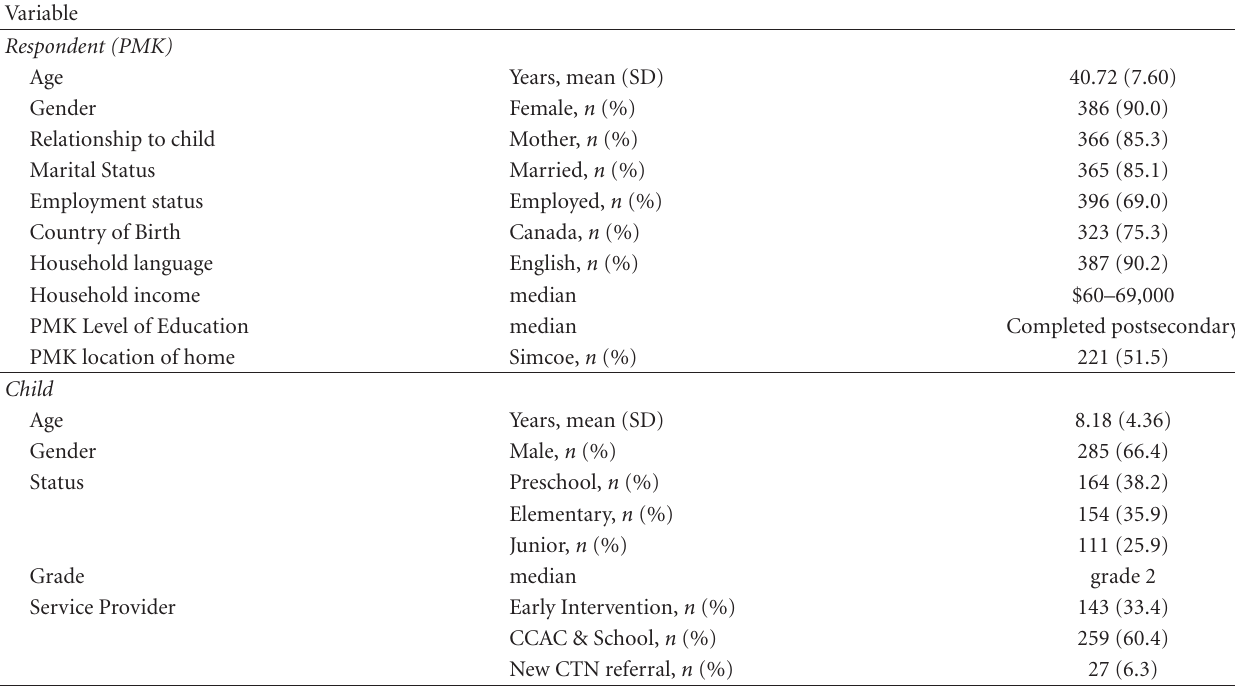
Table 1: Characteristics of sample ( n = 429).